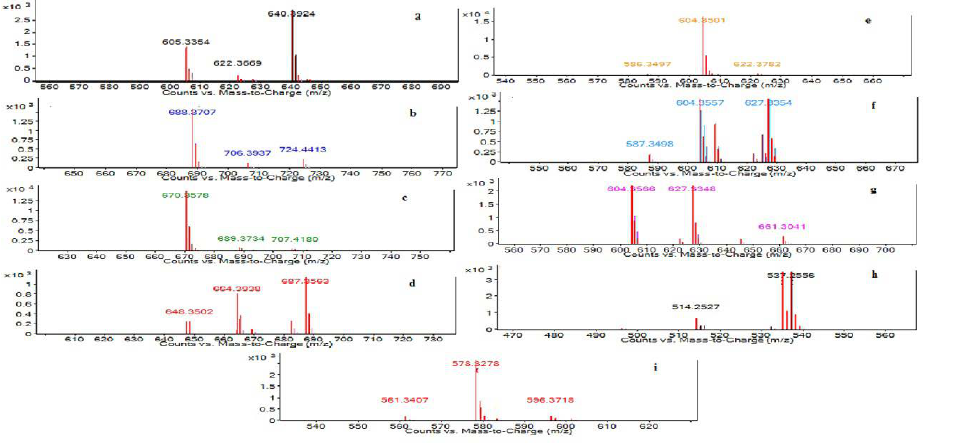
Fig. 8a – 8i. LC–MS Characterization of sophorolipid by Candida tropicalis RA1 [LC–MS run in positive electrospray ionization mode